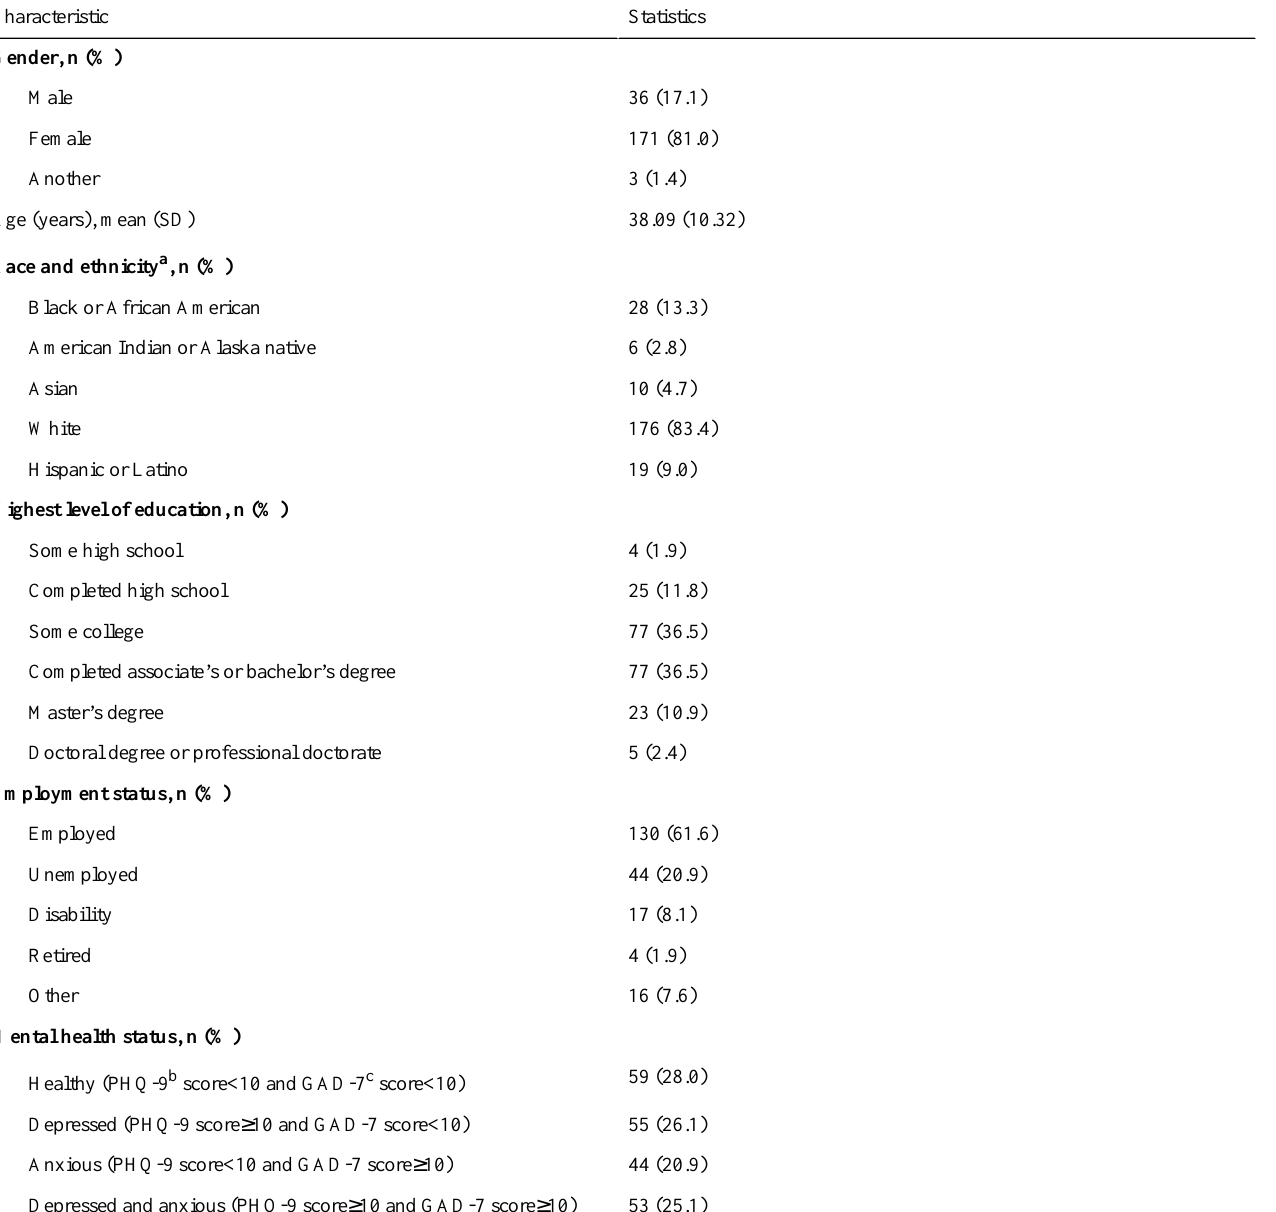
Table 1. Participant characteristics.